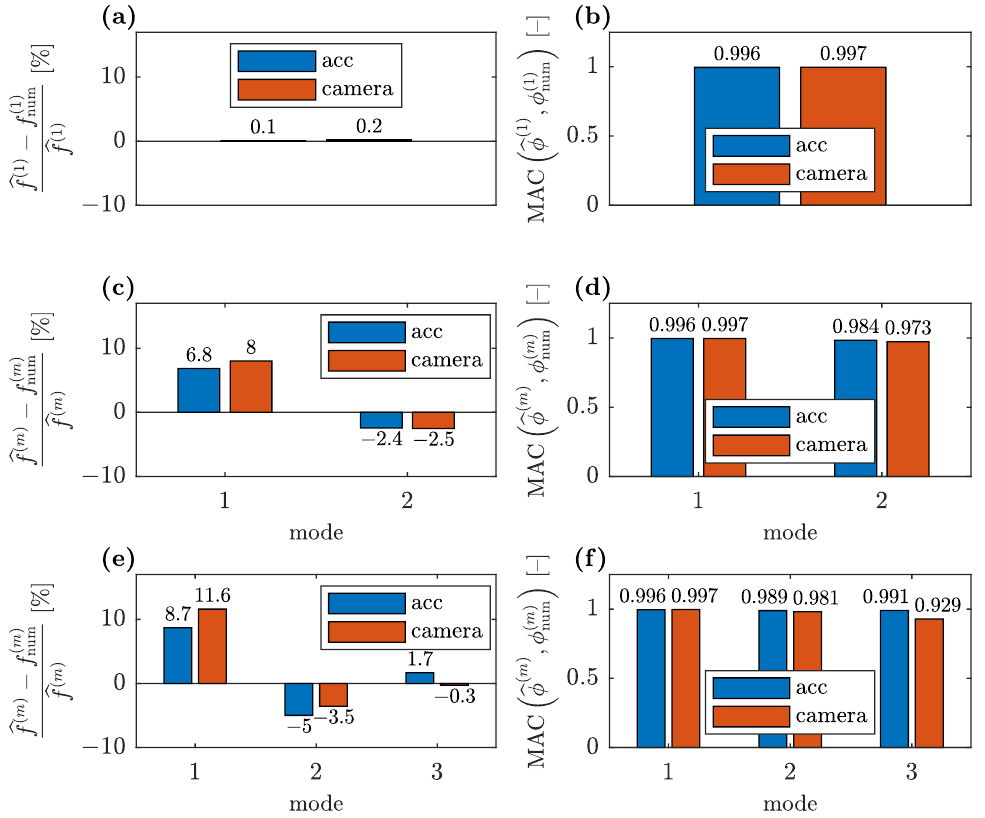
Figure 17. Comparison of the relative natural frequency error and MAC between the numerical and identified modal parameters (for parametrization with two unknown parameters θ 1 and θ 2 ) with the corresponding results for CV-identified modal parameters: ( a , b ) when only the first identified mode is available for model updating; ( c , d ) when two first modes are available; and ( e , f ) when all three identified modes are